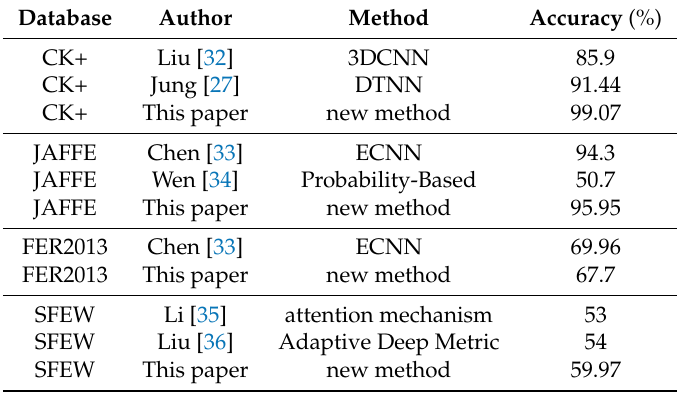
Figure 15. The experimental comparison of different combinations. From left to right, the methods are: the whole face input, the combination of face and eyes, the combination of face and nose, the combination of face and mouth, and the method proposed in this paper. Table 2. This table summarizes the current state of the art in facial expression recognition on four